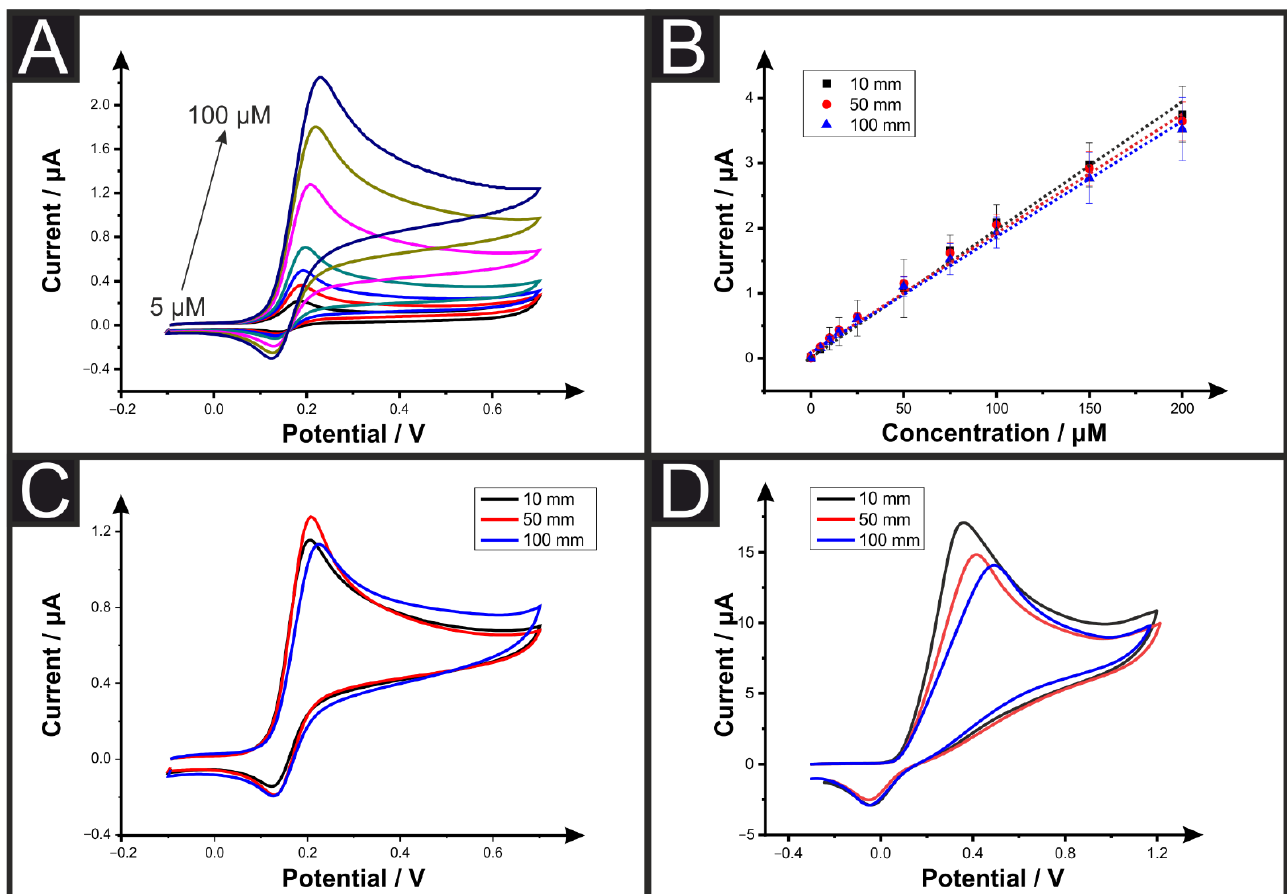
Figure 4. ( A ) Electroanalytical detection of dopamine (5, 10, 15, 25, 50, 75, 100 µ M) using cyclic voltam-